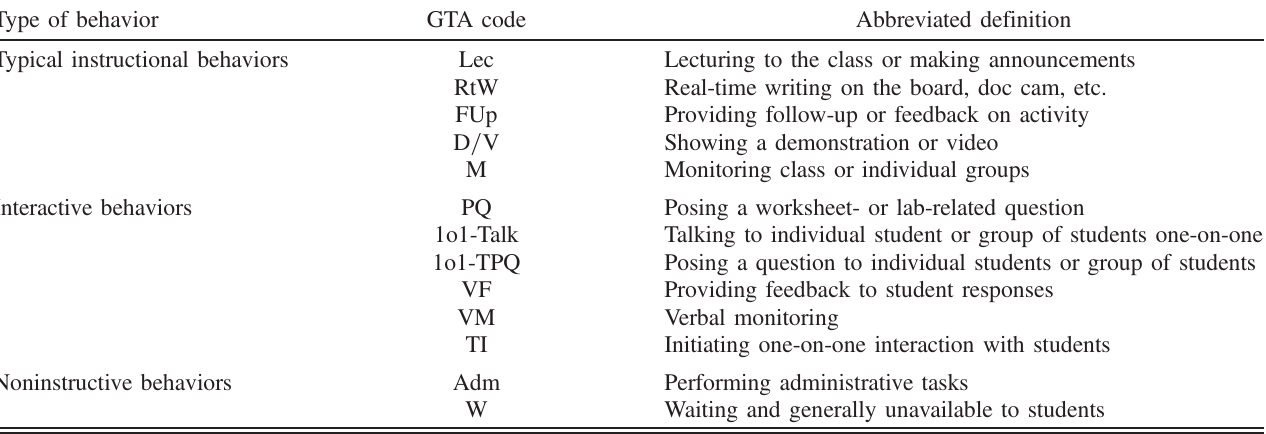
TABLE II. Definitions for codes that describe GTA behaviors.